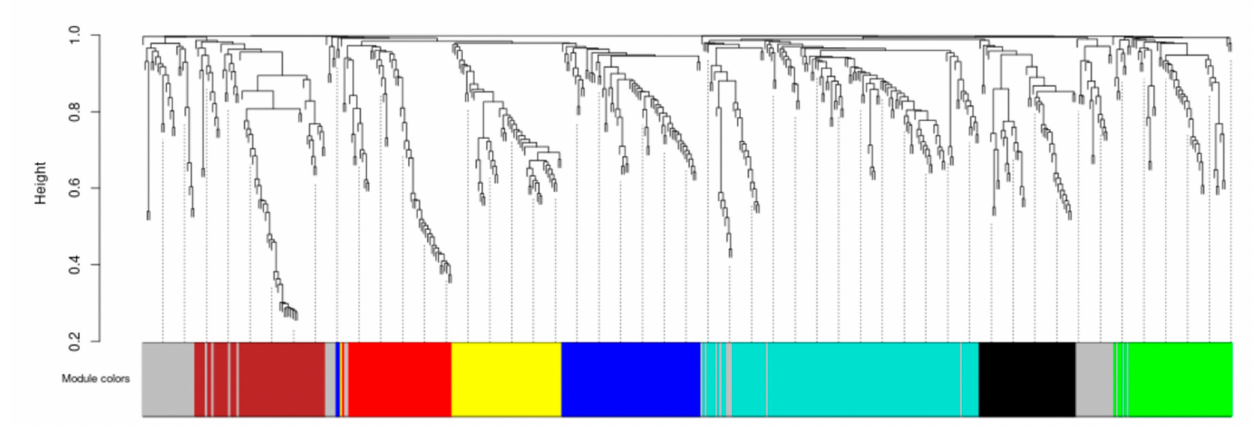
Figure 5. Hierarchical cluster tree displaying 8 co-expression modules. Each branch represents a gene and each color represents a module.